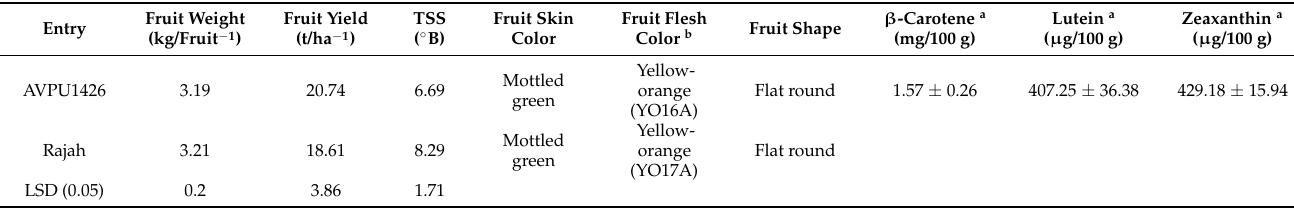
Table 3. Fruit yield, fruit weight, fruit characteristics, and carotenoid content of SLCCNV, SLCPV-TW, and ToLCNDV resistant pumpkin line